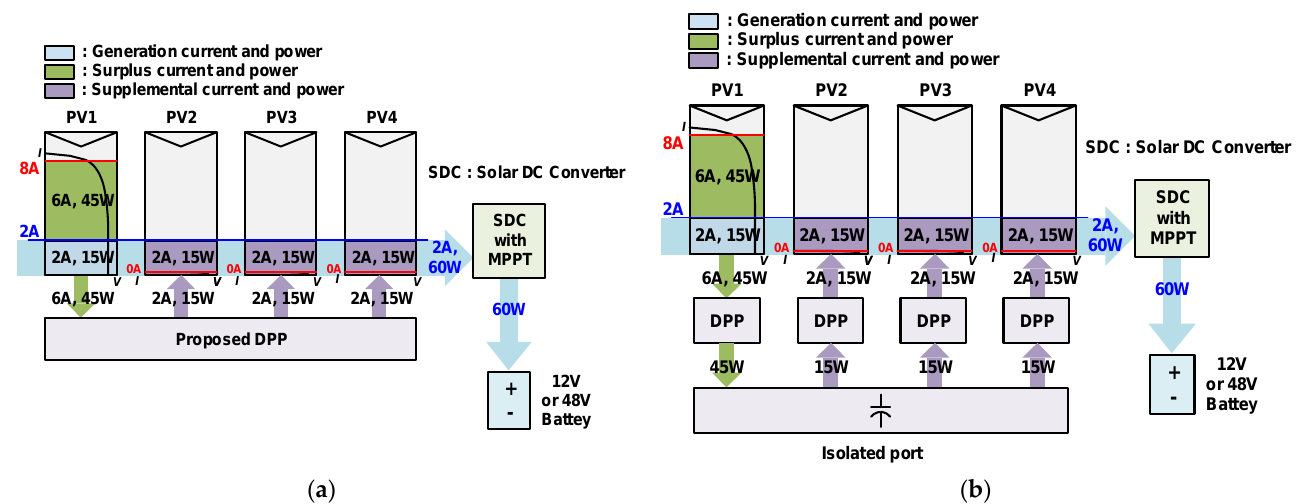
Table 4. Conventional flyback DPP converter parameters.